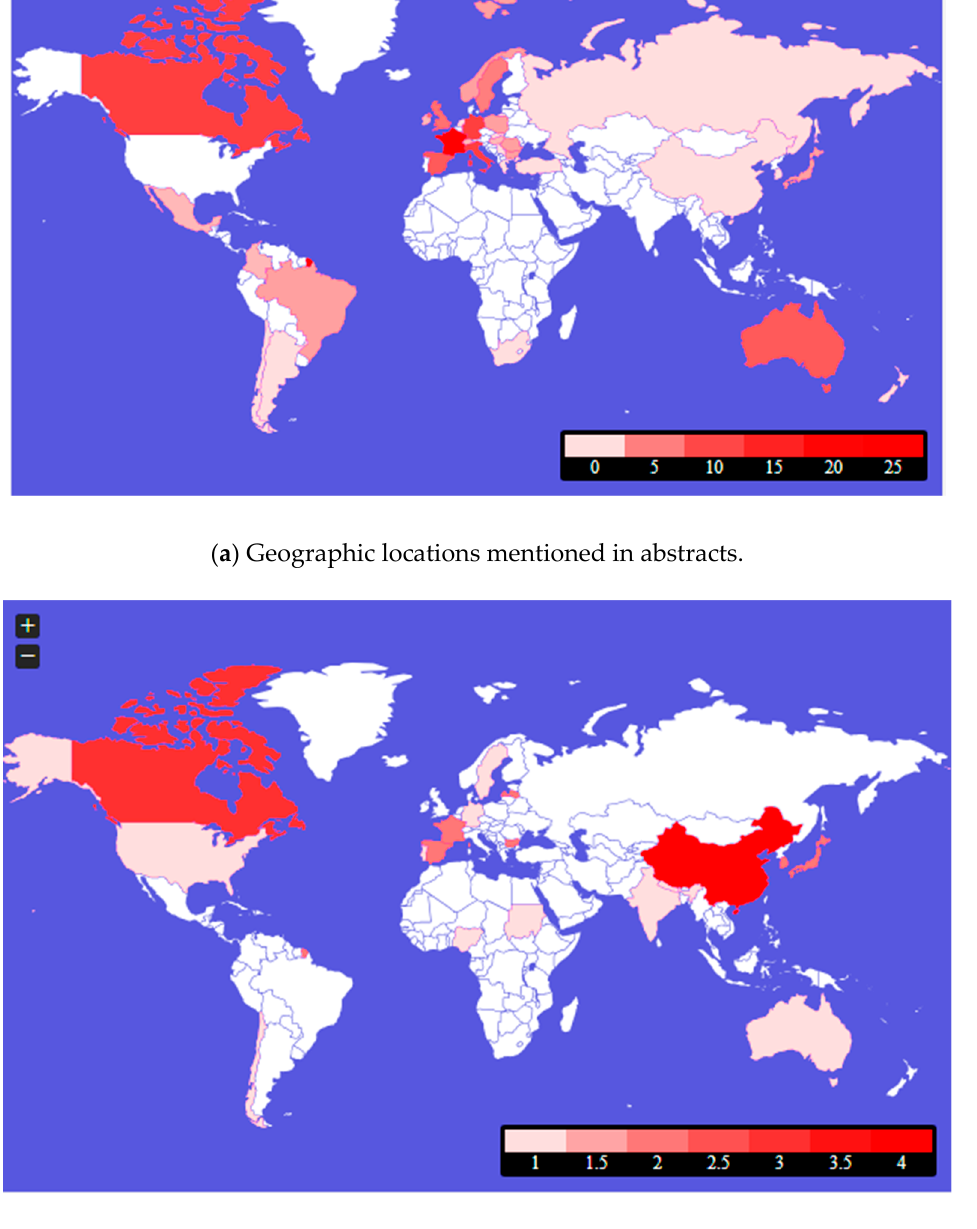
Figure 5. Publications’ content maps from abstracts and keywords. Note: the more intense the color in the legend, the more often the geographic location is mentioned. Source: own elaboration based on 343 references [44–386].